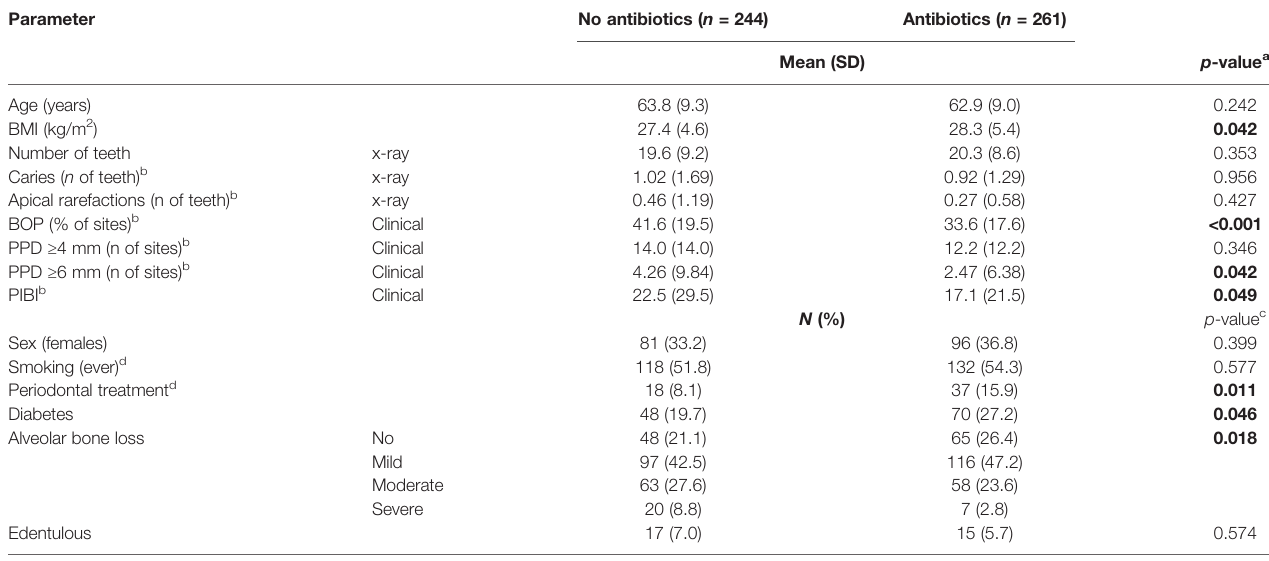
TABLE 1 | Characteristics of the population strati fi ed by the use of antibiotics during the preceding year. Parameter